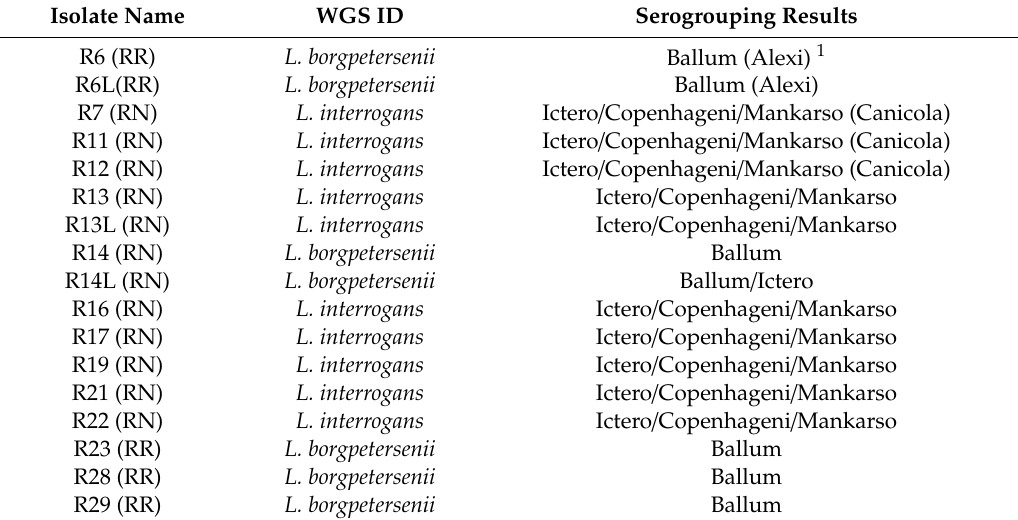
Table 2. Characterization of isolates using whole genome sequencing (WGS) and conventional